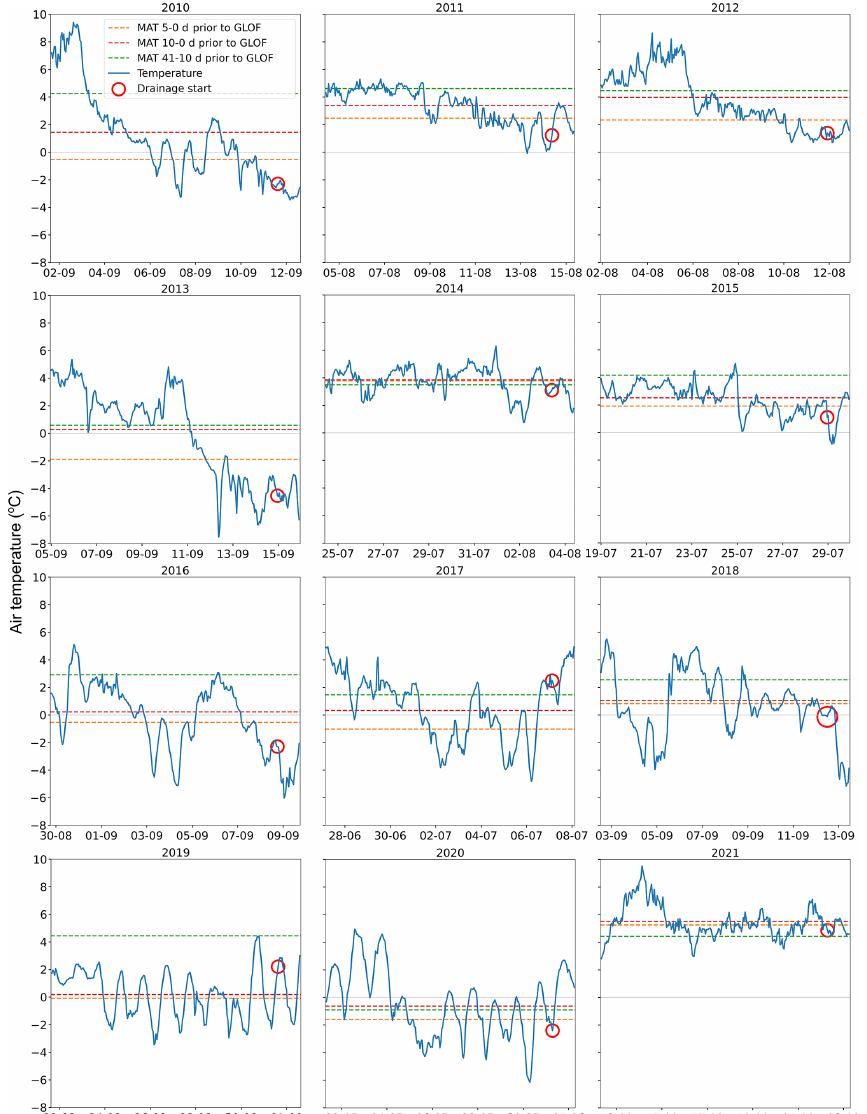
Figure 5. Plot of hourly temperature measurements from 10d prior to the drainage event from KAN_L. The green line shows the mean air temperature (MAT) 41–10d prior to the drainage, the red line shows the MAT 10–0d prior, and the orange line shows the MAT 5–0d prior to drainage. The red circle denotes the start of the GLOF, and for the 2018 event the circle is larger due to uncertainty about the timing. All plots share the same y axis